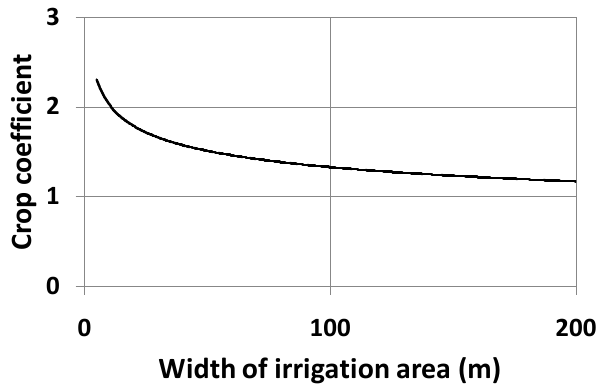
Fig. 3. Effect of an “oasis” environment on irrigation water require- ment (adapted from Allen et al., 1998). In this example, the irriga- tion area is surrounded by dry land and the decreasing crop coeffi- cient indicates the reduction in evaporation as one moves away from the edge of the irrigation